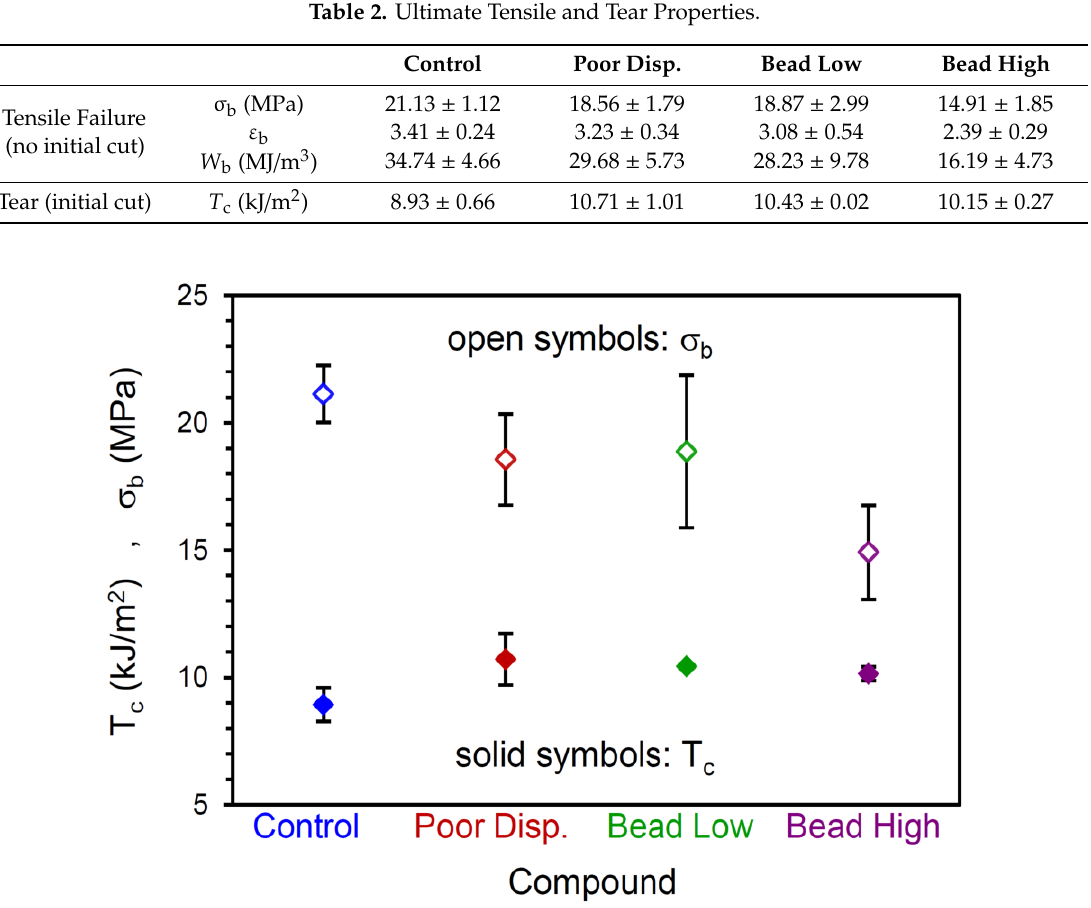
Figure 5. Tensile strength (stress at break, σ b ) and critical tearing energy ( T c ) for the four compounds.